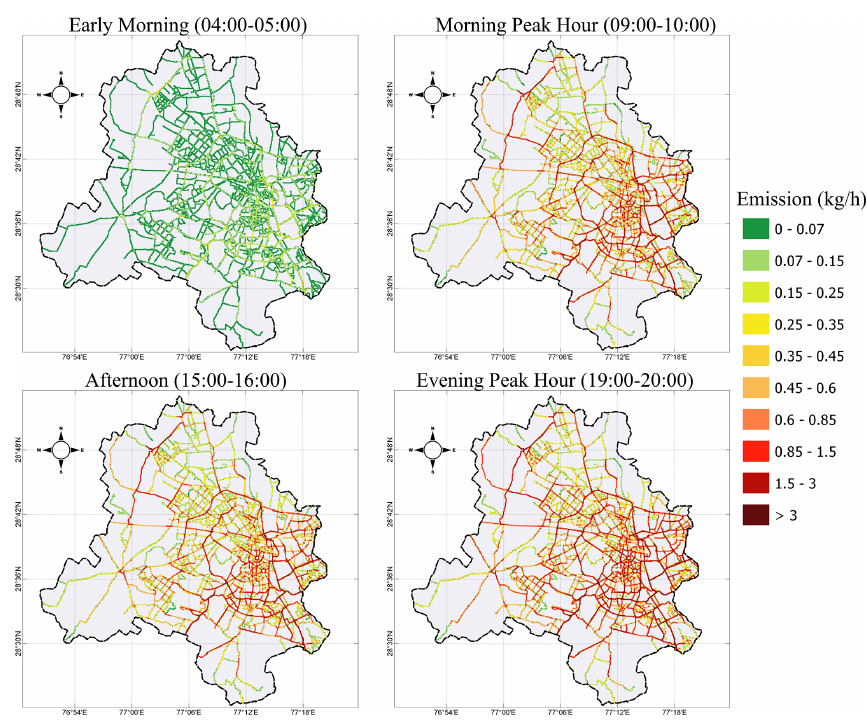
Figure 3. Estimated gridded NO x emission in kgh − 1 (kilogram per hour) at 100m × 100m spatial resolution at different times of the day representative of different congestion